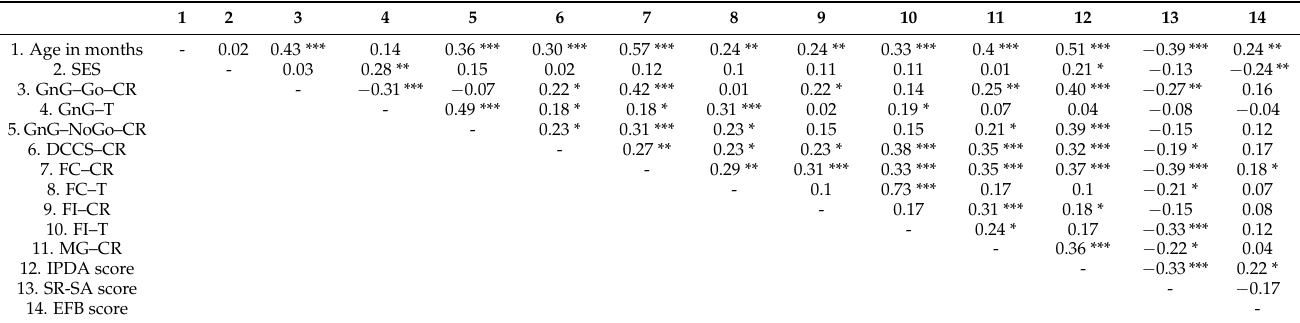
Table 3. Correlations between all